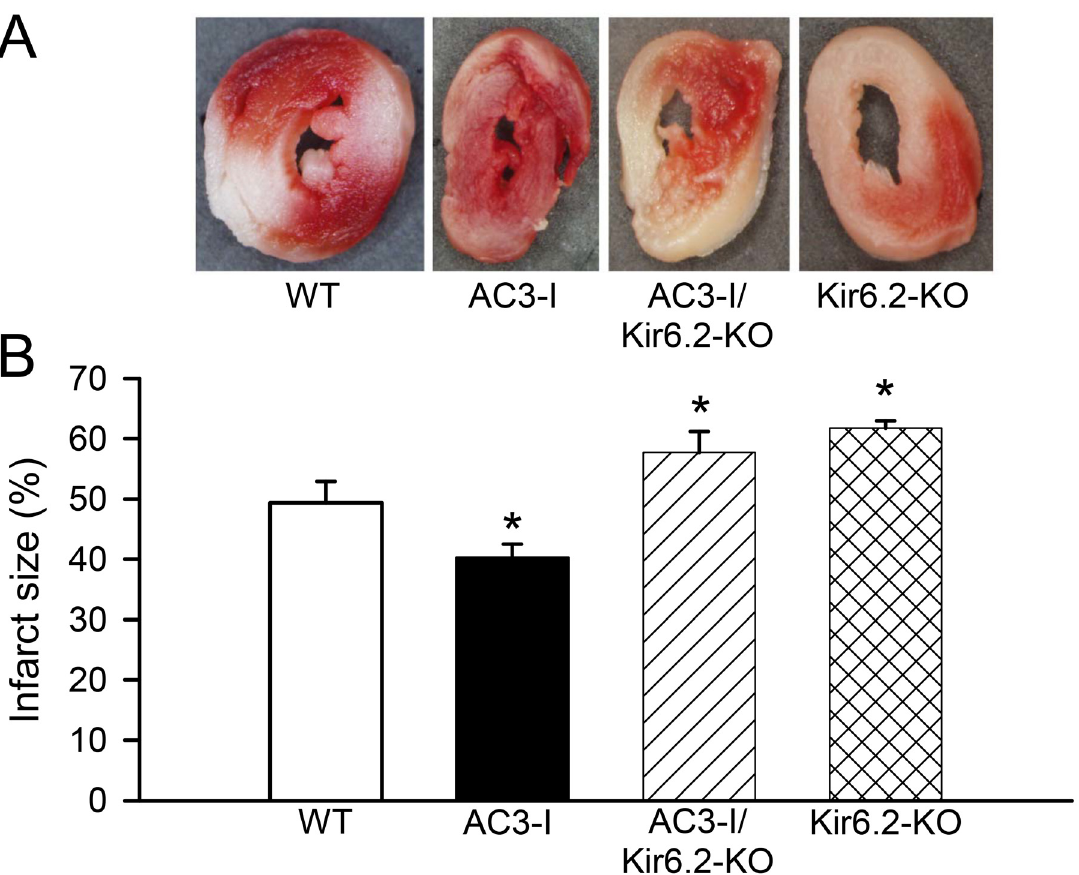
Fig 6. Protective effects of CaMKII inhibition on cardiac ischemia-reperfusion injury is mediated through K ATP channels. A) Representative tetrazolium chloride (TTC) staining of fresh ventricular sections after ischemia-reperfusion injury in 4 groups: wild-type (WT), transgenic mice with cardiac- specific expression of a CaMKII inhibitor (AC3-I), mice with knock out of the cardiac K ATP channel pore-forming subunit, Kir6.2 in combined with transgenic cardiac expression of a CaMKII inhibitor (AC3-I/Kir6.2 KO) and mice with knock out of Kir6.2 only (Kir6.2 KO). B) Summary of normalized myocardial infarction size expressed as the average % tissue area stained by TTC in multiple sections of ventricles in response to ischemia-reperfusion ( * p < .05 vs . WT).